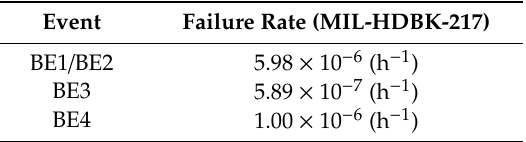
Table 2. Failure and repair rates of the Fault Tree model of the electric motor case study.